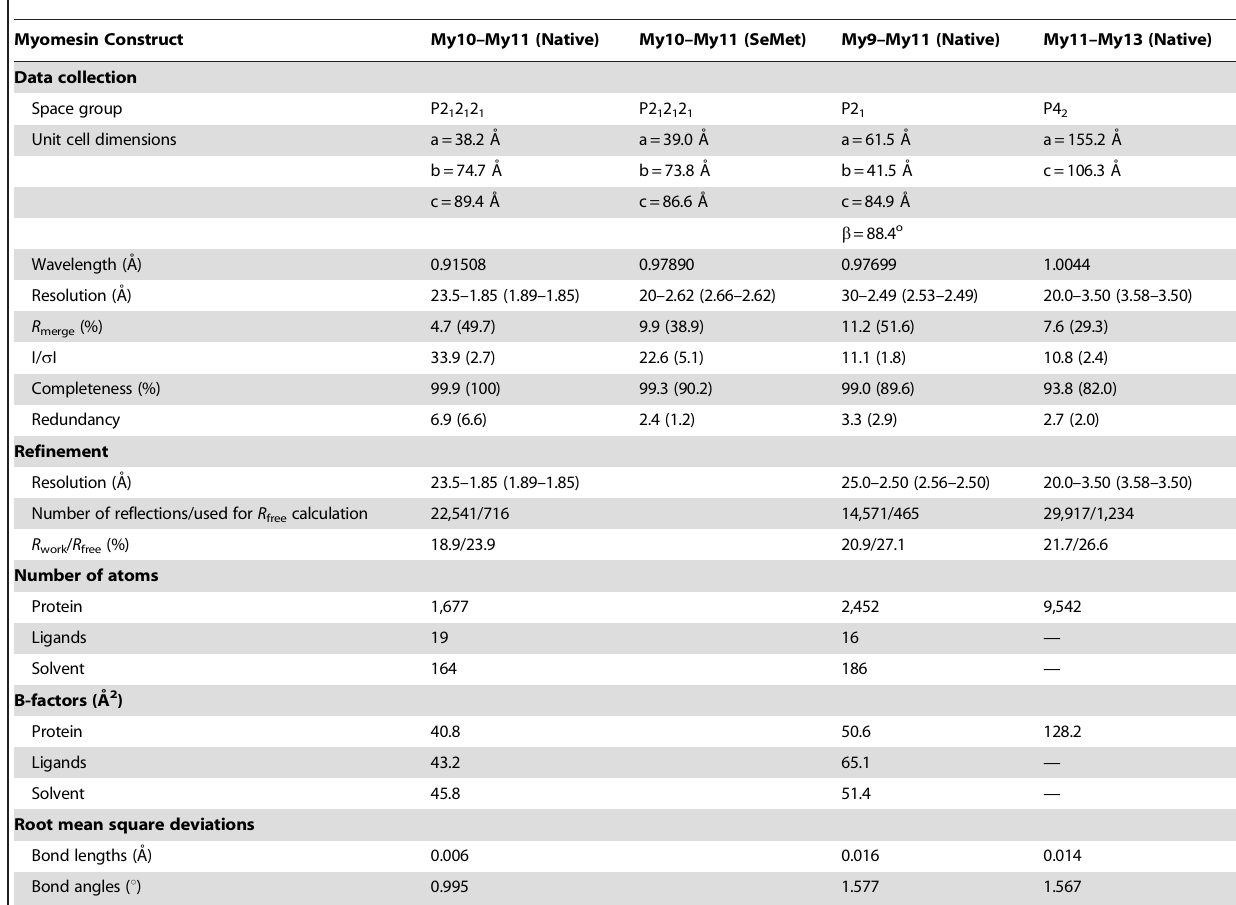
Table 1. X-ray data collection, phasing, and refinement